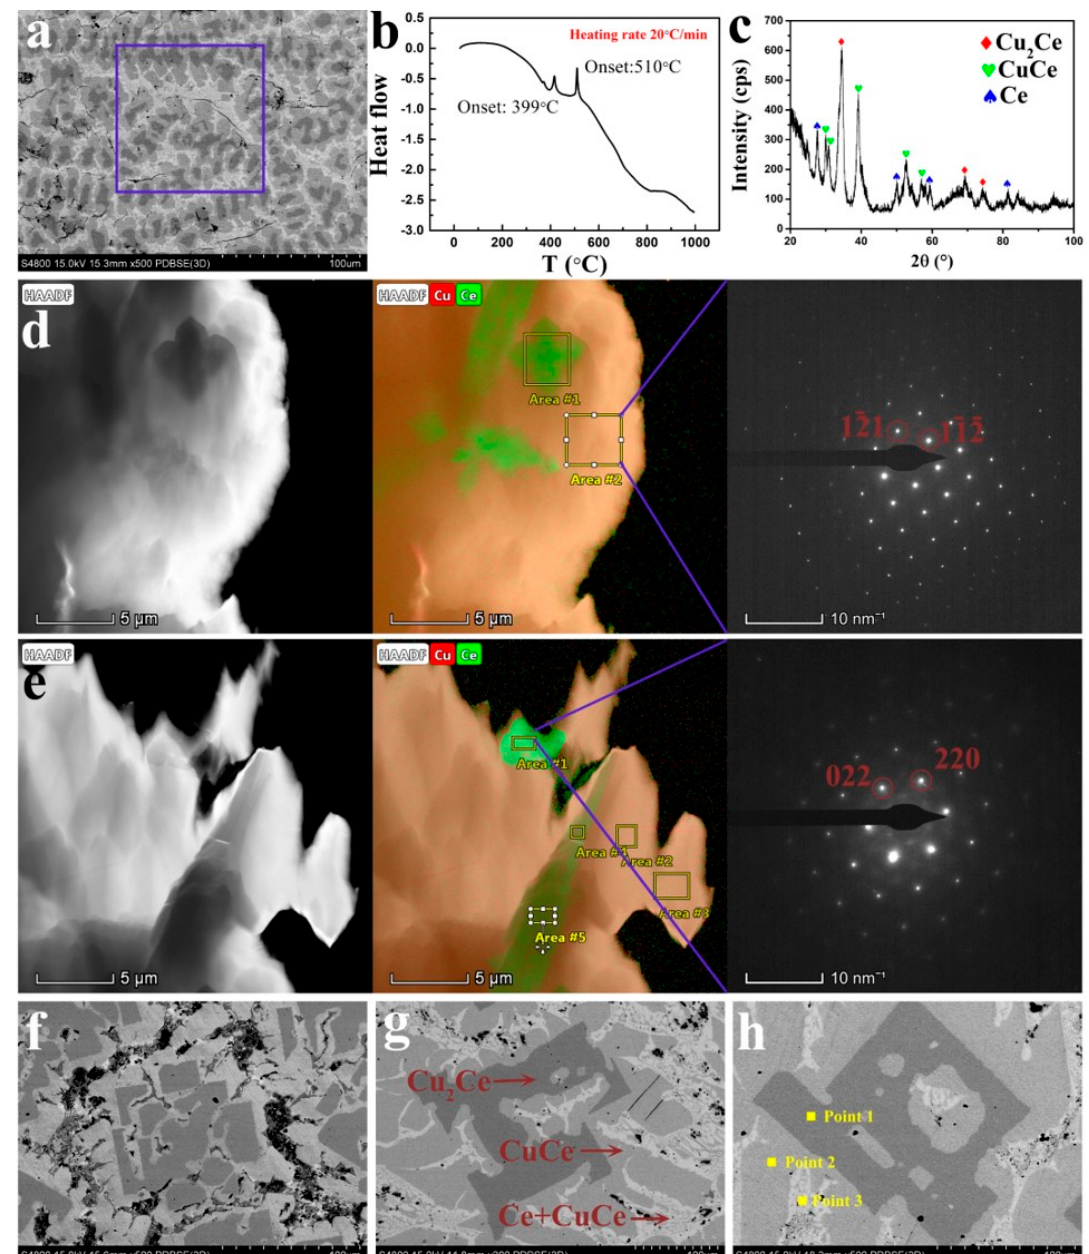
Figure 5. ( a ) Scanning electron microscopy (SEM) image of casting Cu-Ce alloy, ( b ) differential scanning calorimetry (DSC) curve of a Cu-Ce alloy, ( c ) X-ray diffraction spectrum of casting Cu-Ce alloy. ( d , e ) Transmission electron microscopy (TEM) dark field image of Cu-Ce alloy, corresponding energy dispersive spectrometry (EDS) and selected area electron diffraction pattern. ( f – h ) SEM images with a withdrawal rate of 100, 25, and 10 μ m/s.